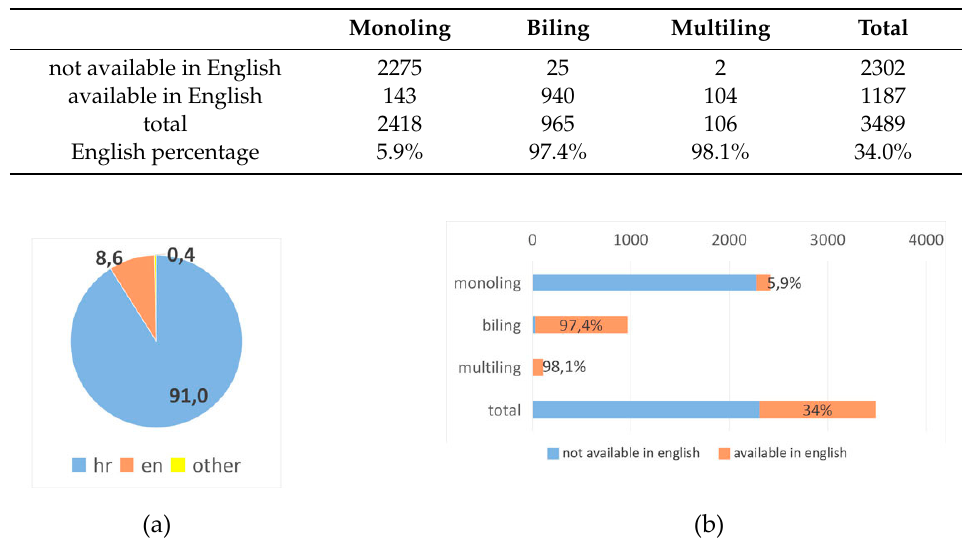
Figure A4. Visualization of the results for domain hr. ( a ) Primary languages pie chart and ( b ) English language availability bar chart.